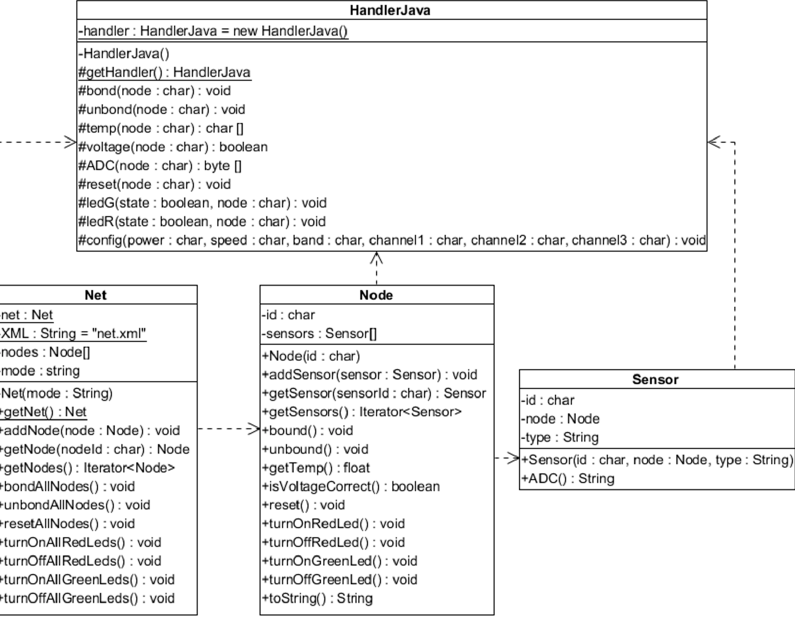
Figure 5. UML diagram for the Java wrapping.